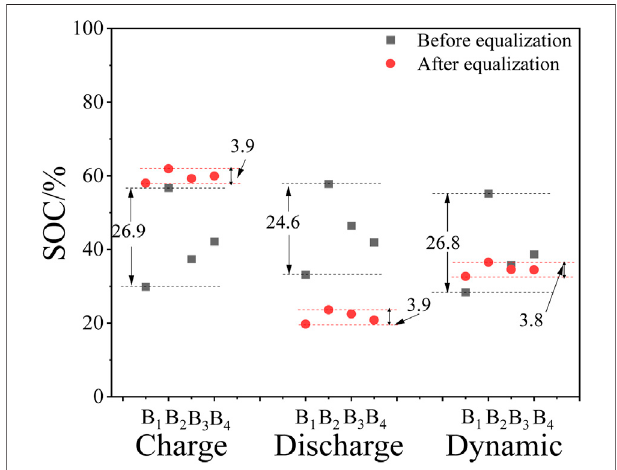
FIGURE 15 | SOC change before and after